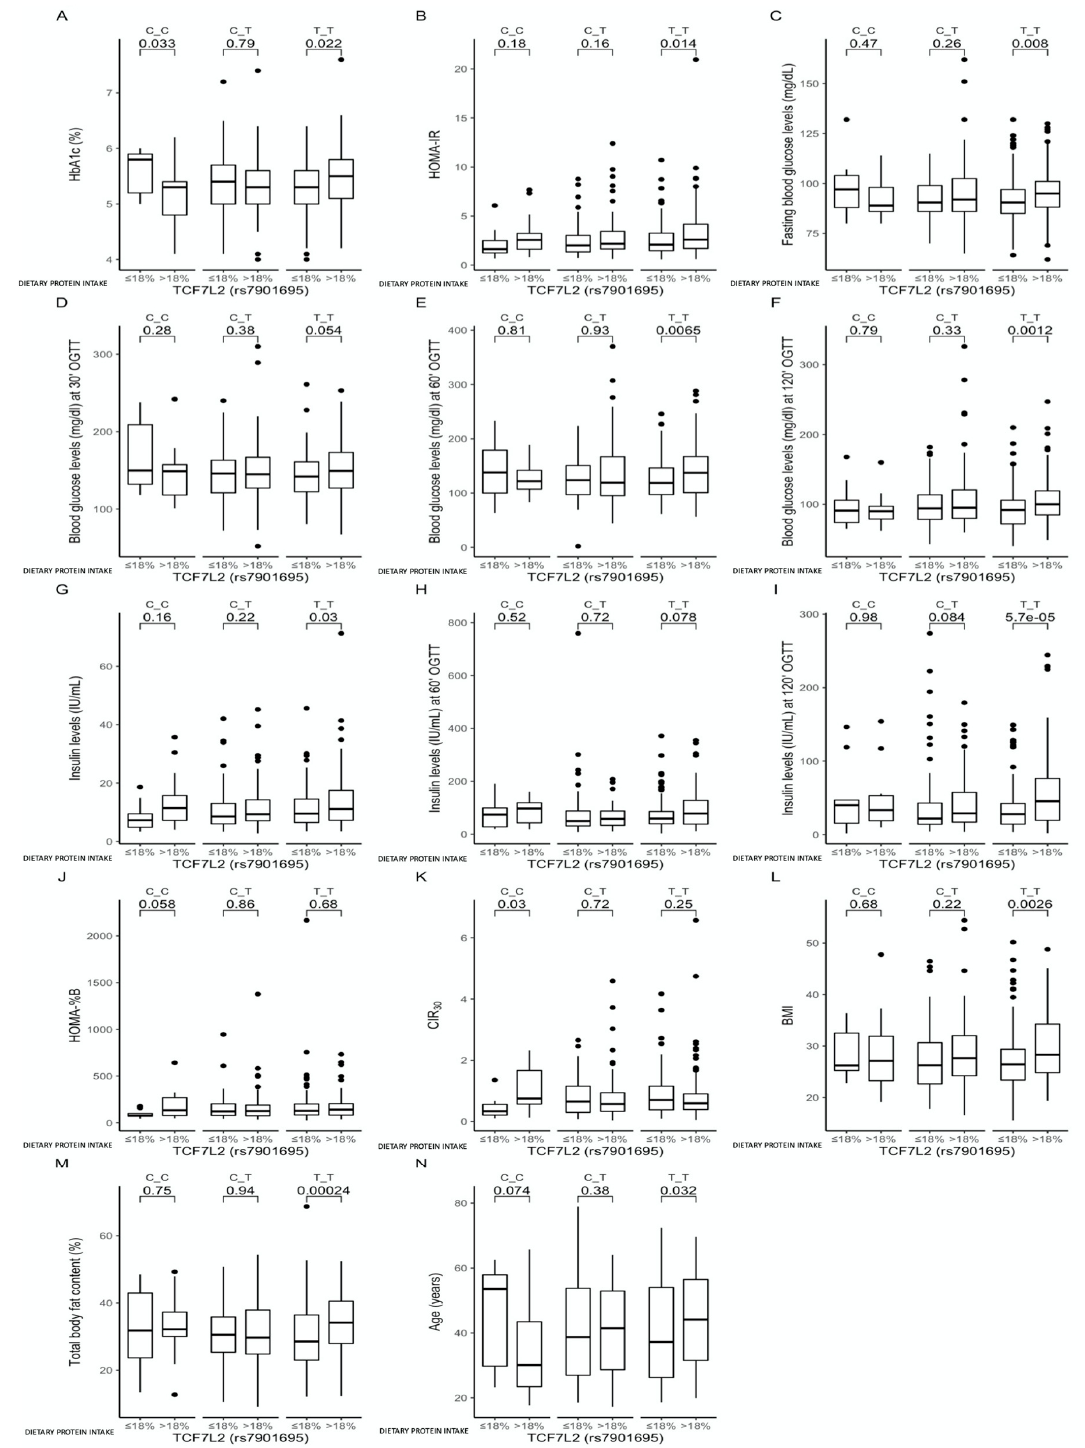
Figure 2. Association of dietary protein intake ≤ 18% and > 18% of total daily energy intake with ( A ) HbA1c (%), ( B ) HOMA- IR, ( C ) fasting blood glucose levels (mg/dL), ( D ) blood glucose levels at 30 min of OGTT (mg/dL), ( E ) blood glucose levels at 60 min of OGTT (mg/dL), ( F ) blood glucose levels at 120 min of OGTT (mg/dL), ( G ) fasting insulin levels (IU/mL), ( H ) insulin levels at 60 min of OGTT (IU/mL), ( I ) insulin levels at 120 min of OGTT (IU/mL), ( J ) HOMA-B, ( K ) CIR30, ( L ) BMI (kg/m 2 ), ( M ) total body fat content (%), and ( N ) age (years), in the TCF7L2 rs7901695 genotype carriers. The differences in median values of the selected responses and the interquartile ranges (IQRs) in different genotypic and dietary strata are presented.